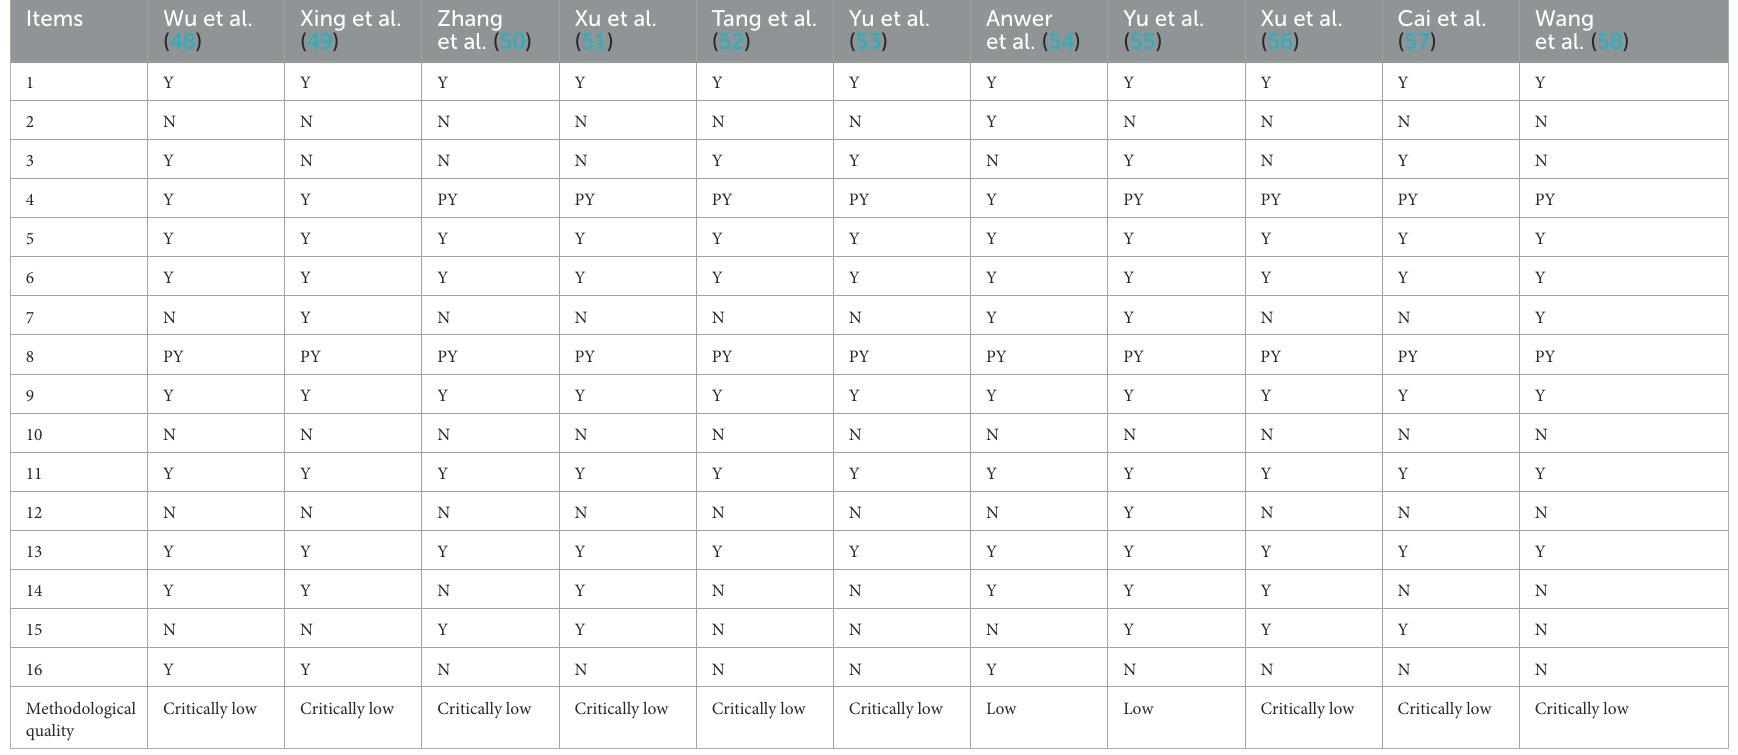
TABLE 3 Results of the AMSTAR-2